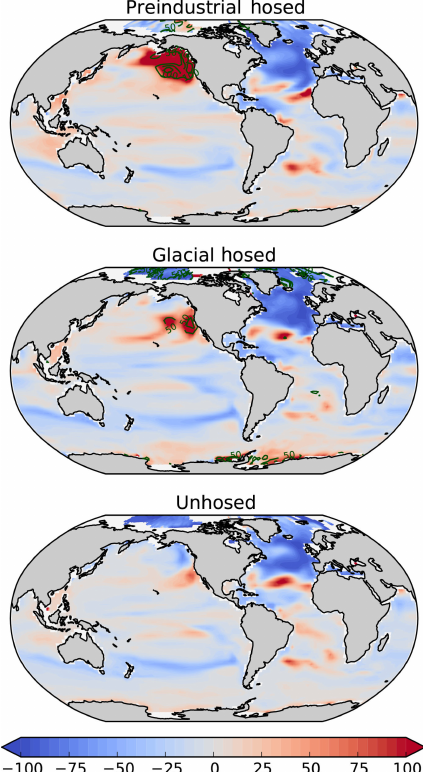
Figure 9. Stadial export production anomaly. The top two panels show the ratio of organic matter export at 100m between weak and strong AMOC states (as defined in Fig. 3) under preindustrial and glacial boundary conditions, averaged between the four sets of or- bital configurations (see Fig. S8 to view all eight hosing simulations individually). Green contours show the standard deviation between the four sets of orbital configurations at 50% intervals. The bottom panel shows the ratio of export between weak and strong AMOC states (as defined in Fig. 3) in the unhosed simulation. Shading and contours in %.